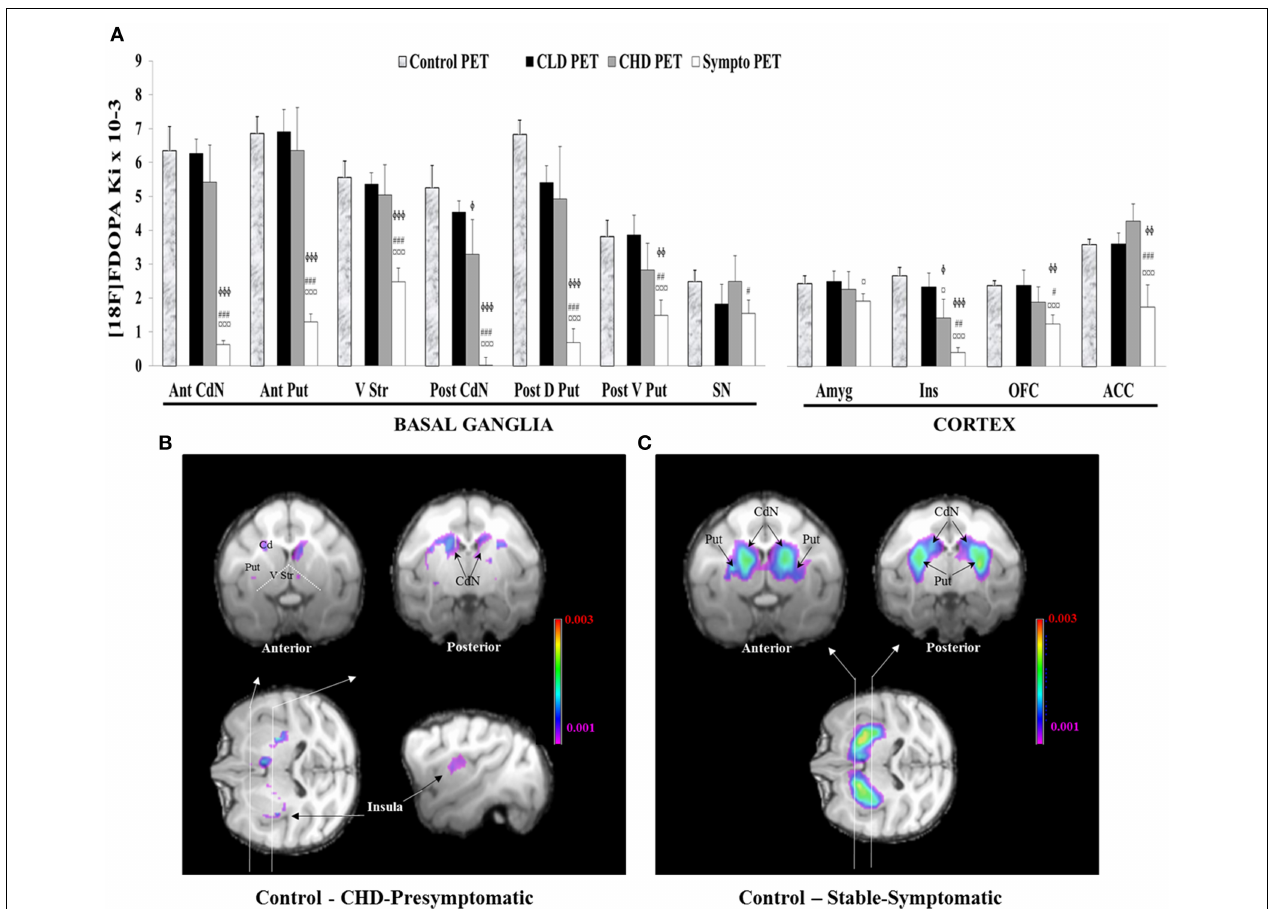
FIGURE 7 | Comparisons of 18 F-DOPA uptake in PET imaging. (A) The rate of specific uptake (Ki values) was assessed within basal ganglia in relation to 18 F-DOPA uptake in the reference brain region (cerebellum). The basal ganglia includes the Anterior and Posterior Caudate Nucleus (Ant CdN/Post CdN), the AnteriorPutamen(AntPut),thePosteriorDorsalandVentralPutamen(PostD/V Put),theVentralStriatum(VStr)andtheSubstantiaNigra(SN),aswellasuptake incorticalregionssuchastheAnteriorCingulateCortex(ACC),theOrbitofrontal Cortex (OFC), the Amygdala (Amyg) and the Insula (Ins). One PET scan